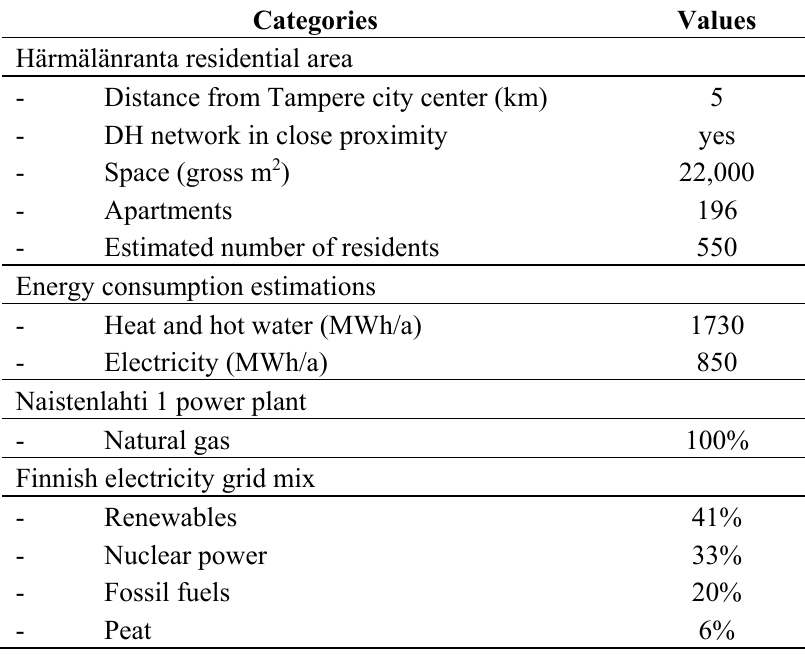
Table 1. Case Härmälänranta key